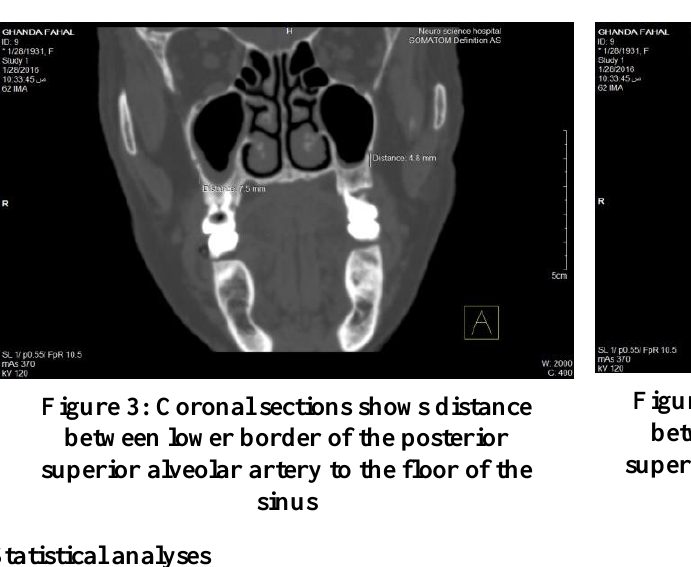
Figure 2: Coronal sections shows distance between lower border of the posterior superior alveolar artery to the alveolar crest